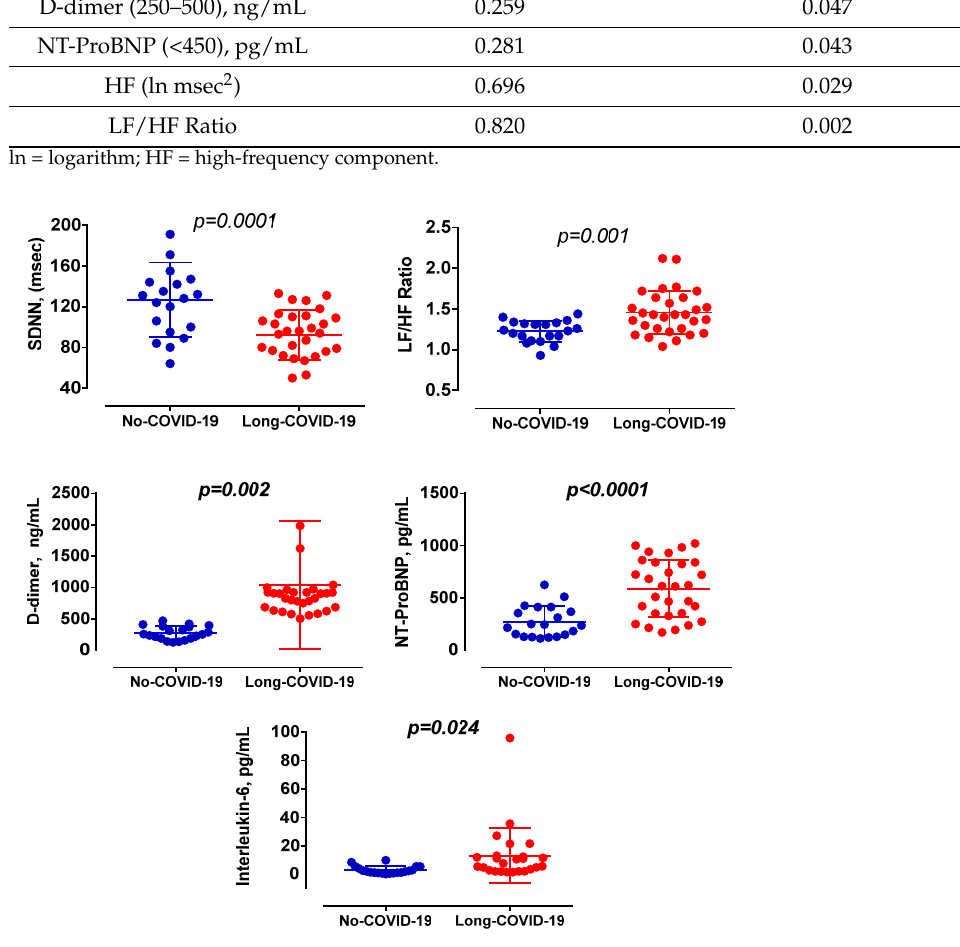
Table 4. Multivariable analysis for Long-COVID-19.